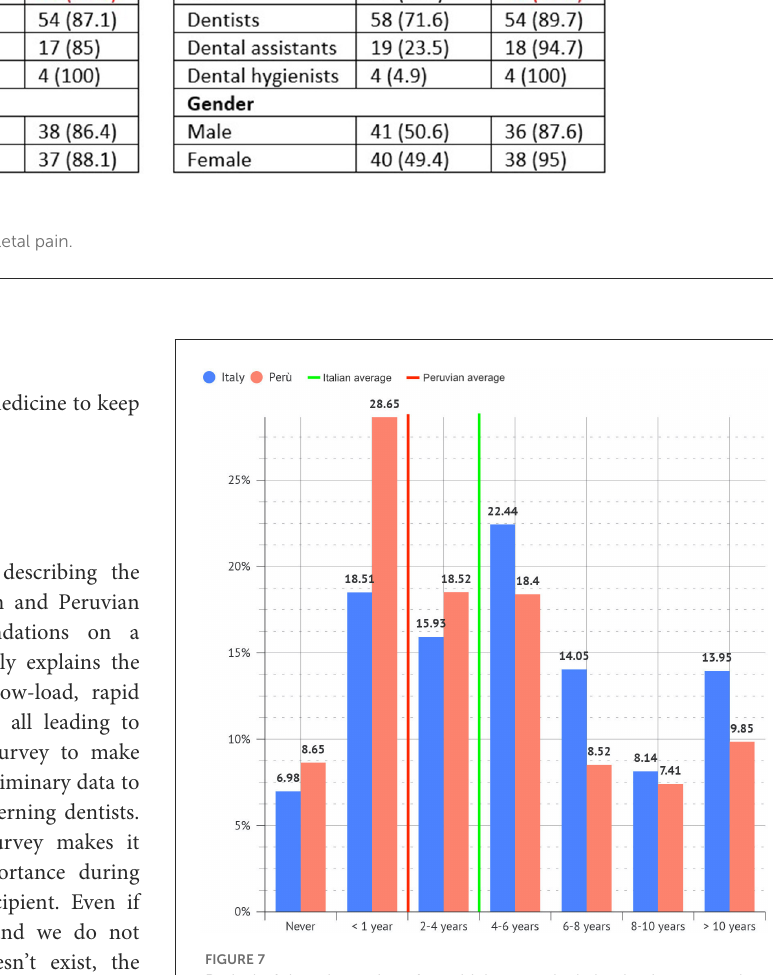
FIGURE7 Period of dental practice after which musculoskeletal pain